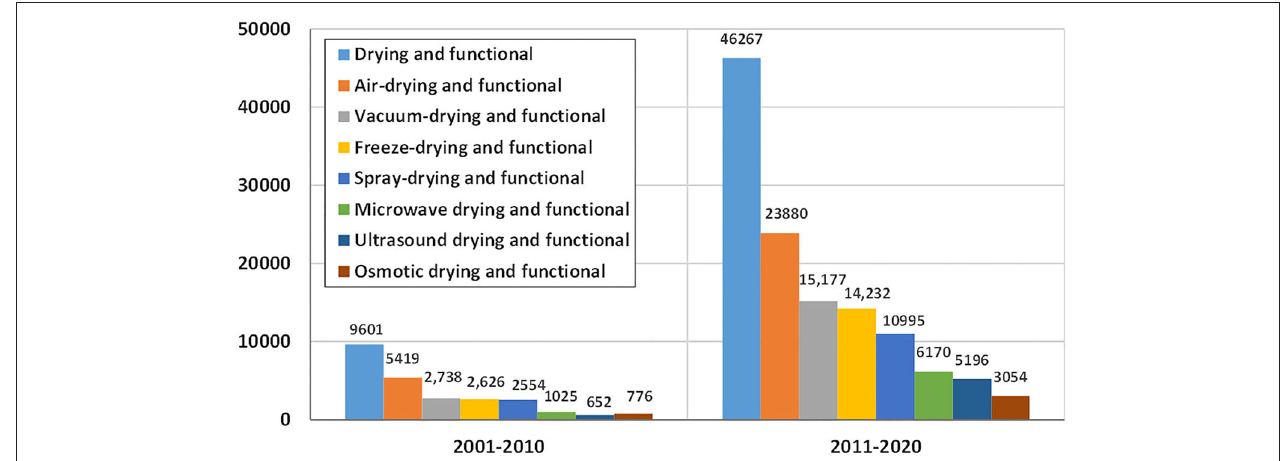
FIGURE 2 | Dehydration techniques applied in the process of functional food or functional ingredients obtention. Average number of articles retrieved when using each technique combined with the terms “functional food powder,” “functional ingredient,” or “bioactive